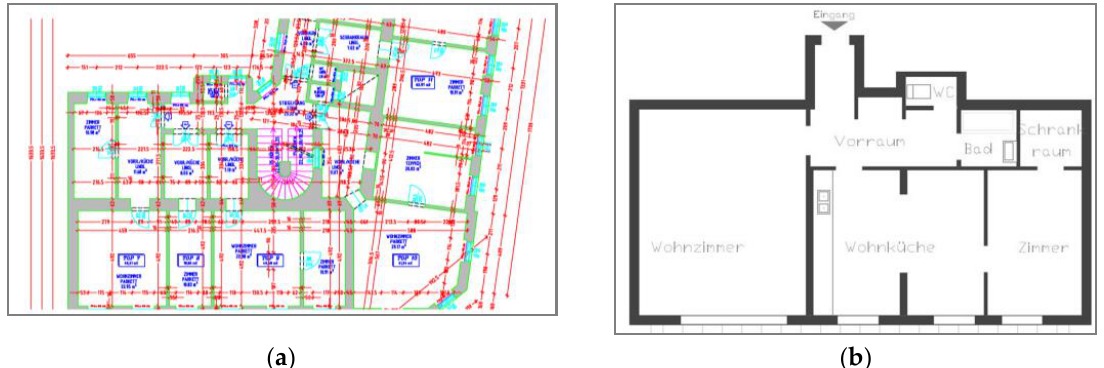
Figure 2. Floor plans with a different purpose and different abstraction levels. Left image ( a ) shows a cluttered drawing with dimensions and multiple elements. On the right ( b ), a schematic simplified description of the structure of an apartment can be seen.